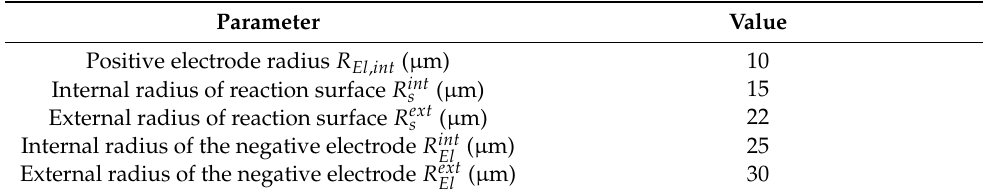
Table 2. Geometrical parameters for the second biosensor model. Parameter